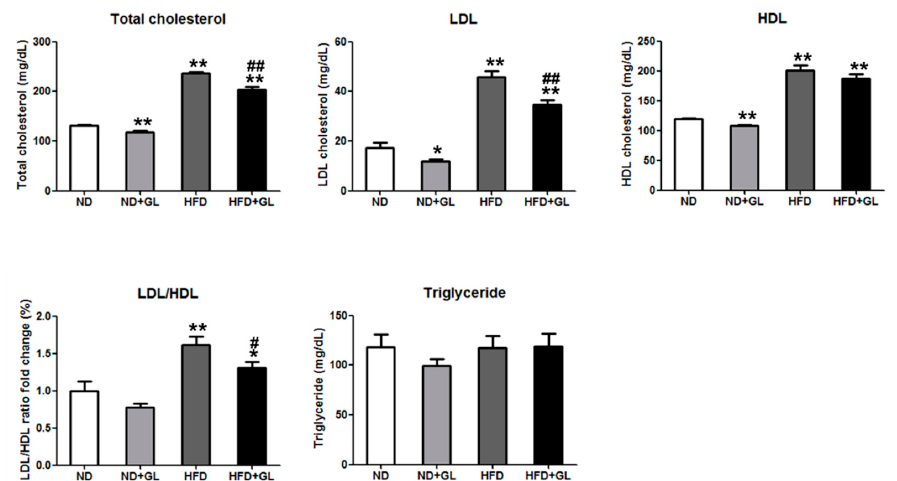
Figure 3. GL attenuated the increases in serum cholesterol and low-density lipoprotein (LDL) levels in HFD-fed mice. GL (50 mg/kg) or vehicle was orally administered five days/week in the mice fed with normal diet (ND) or high fat diet (HFD). Serum were collected to measure total cholesterol, triglyceride, LDL, and HDL levels after 16 weeks of GL treatment ( n = 8–9 for each group). Data are the means ± SEM. * p < 0.05 and ** p < 0.01 vs. ND group; # p < 0.05 and ## p < 0.01 vs. HFD group.